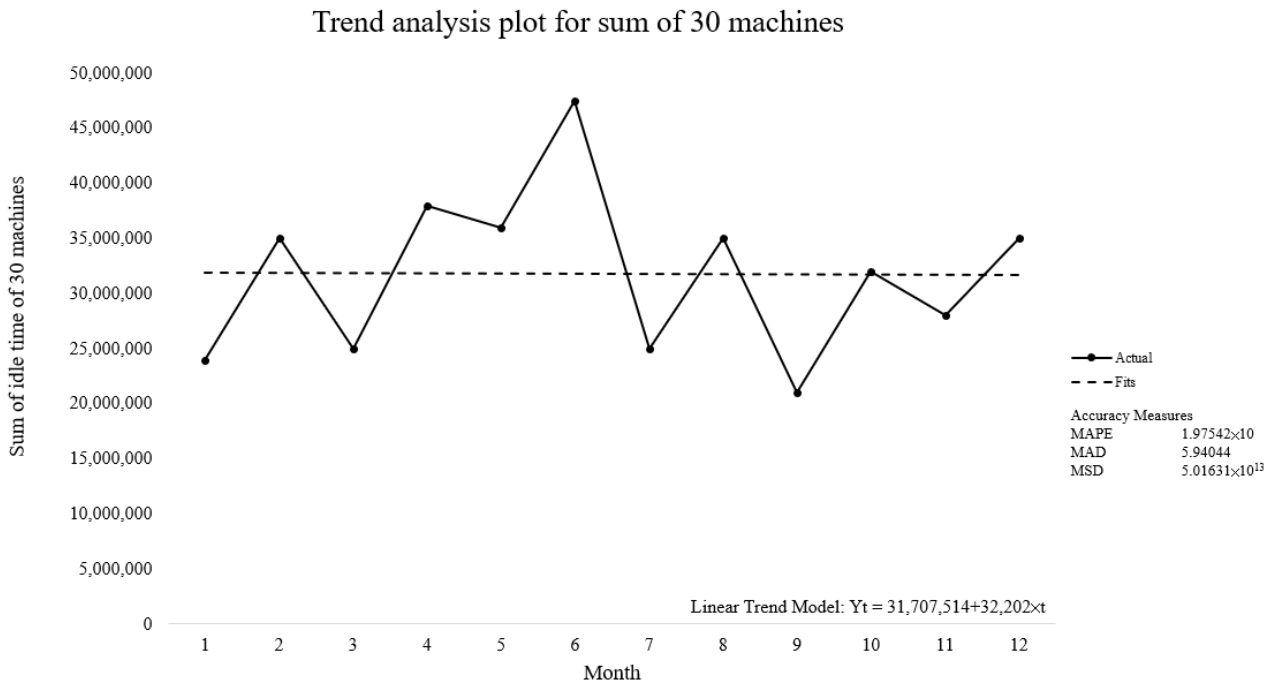
Figure 6. The relationship between idle time and time before the removal of outliers.